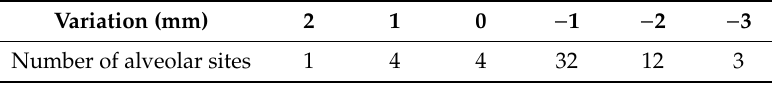
Figure 4. Alveolar ridge width preservation. The efficacy of the composite of HA/ β -TCP + collagen in preserving the alveolar bone width was good. * Significant difference between preoperative and later measurements: p < 0.05. Table 3. Di ff erences in alveolar site widths three months after extraction.